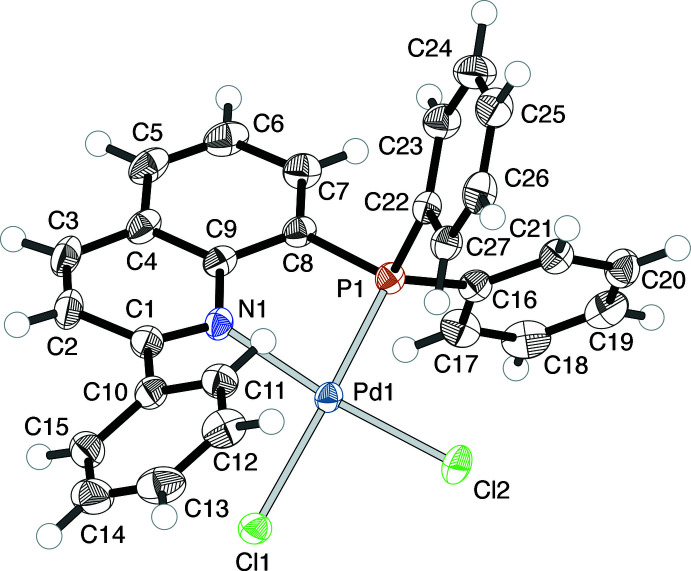
The mol­ecular structure of [PdCl2(PQPh)] (2), showing the atom-numbering scheme and displacement ellipsoids at the 50% probability level.